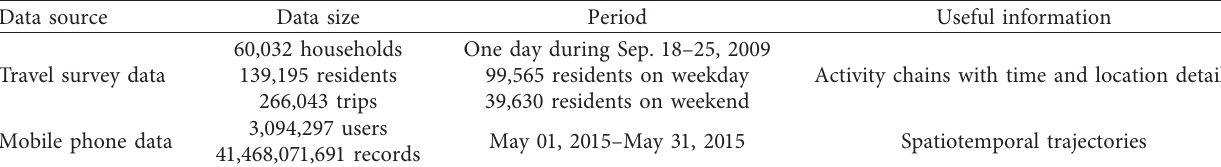
Table 1: Description of two